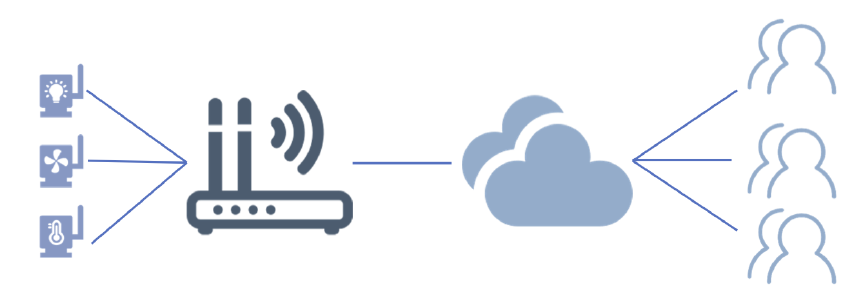
Figure 1. Internet of